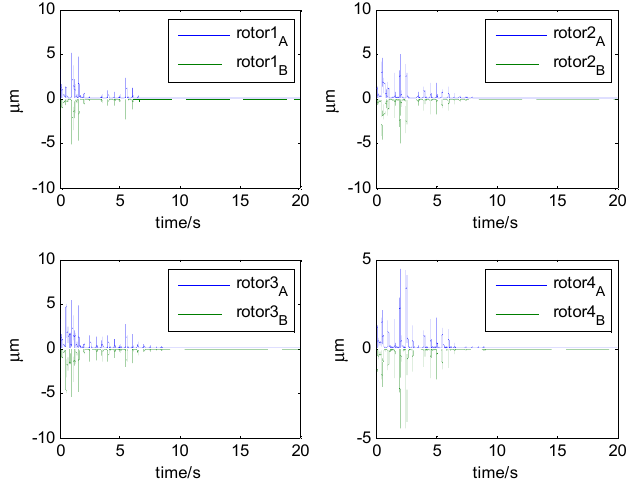
Figure 17. The magnitude of the rotor displacement with feedforward compensation.